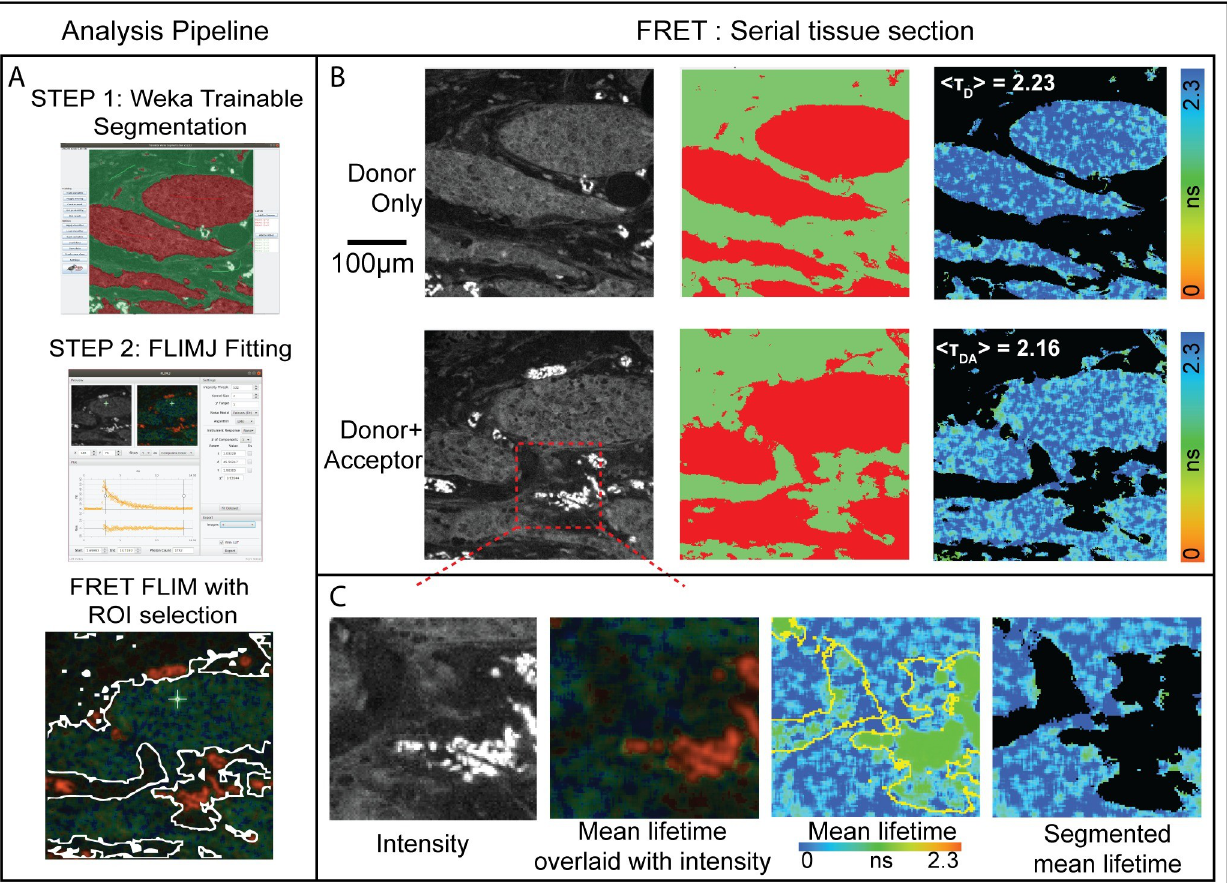
Fig 2. A) Breast cancer tissues from 107 patients METABRIC study were stained with antibodies: anti-HER3-IgG-Alexa546 (donor) and anti- HER2-IgG-Cy5 (acceptor) [37]. Serial sections were stained with donor+acceptor (DA, FRET pair) and with donor alone (D, control). Average lifetime values (T D and T DA ) can be determined for the tumor from the two serial sections using FLIMJ after segmentation. The FRET efficiency can be calculated according to FRETeff = 1 –TDA/TD. B) Weka Trainable Segmentation plugin was used to segment the tissue areas. The FLIMJ user interface showing a typical transient and fit from the tissue. We used the LM fitting with a mono-exponential model. C) Zoom into a smaller region. Composite image from FLIMJ showing lifetime information. Pure lifetime map with Weka segmentation shown in yellow. Segmentation result of the lifetime within the tumor with artifactual tissue removed. From T D = 2.23 ns and T DA = 2.16 ns, we estimate a FRET efficiency for this example tumor area as 3.1% as a measure of HER2-HER3 dimerization on the tumor in this patient.